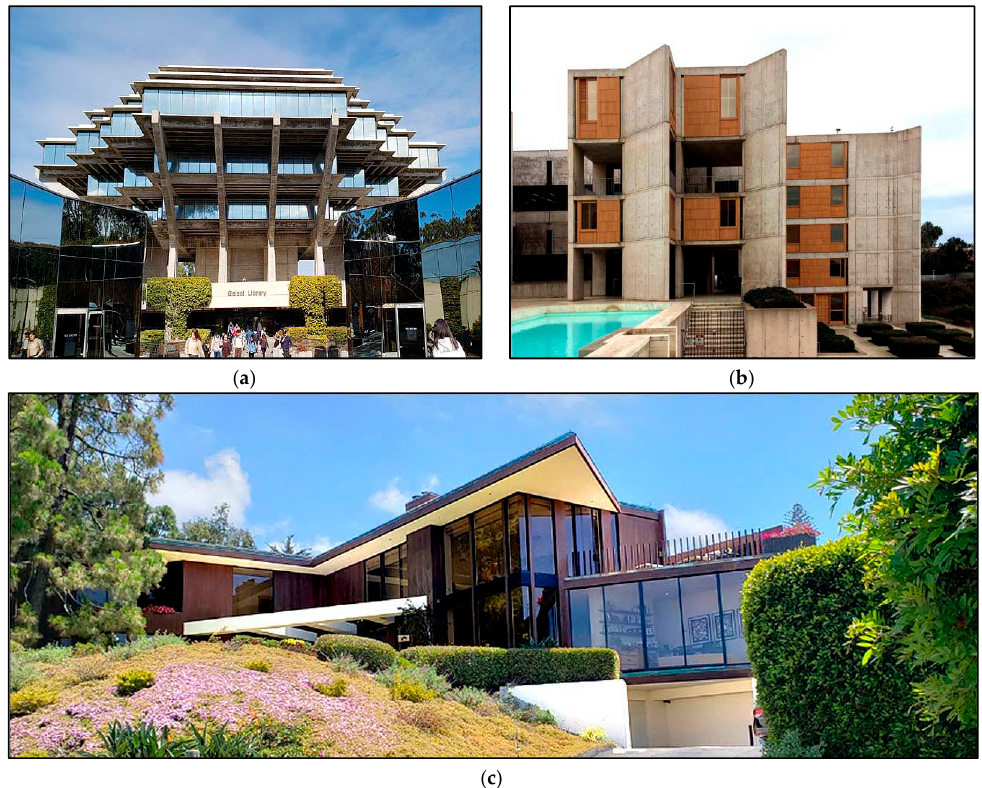
Figure 15. The Architecture of University of California, San Diego, and its Neighbors. ( a ) Geisel Library, UCSD (1970); ( b ) Offices, Salk Laboratories (1963); ( c ) Single Family Residence in La Jolla (circa 2019). Image Credits: © 2019 Jeremy Kargon.